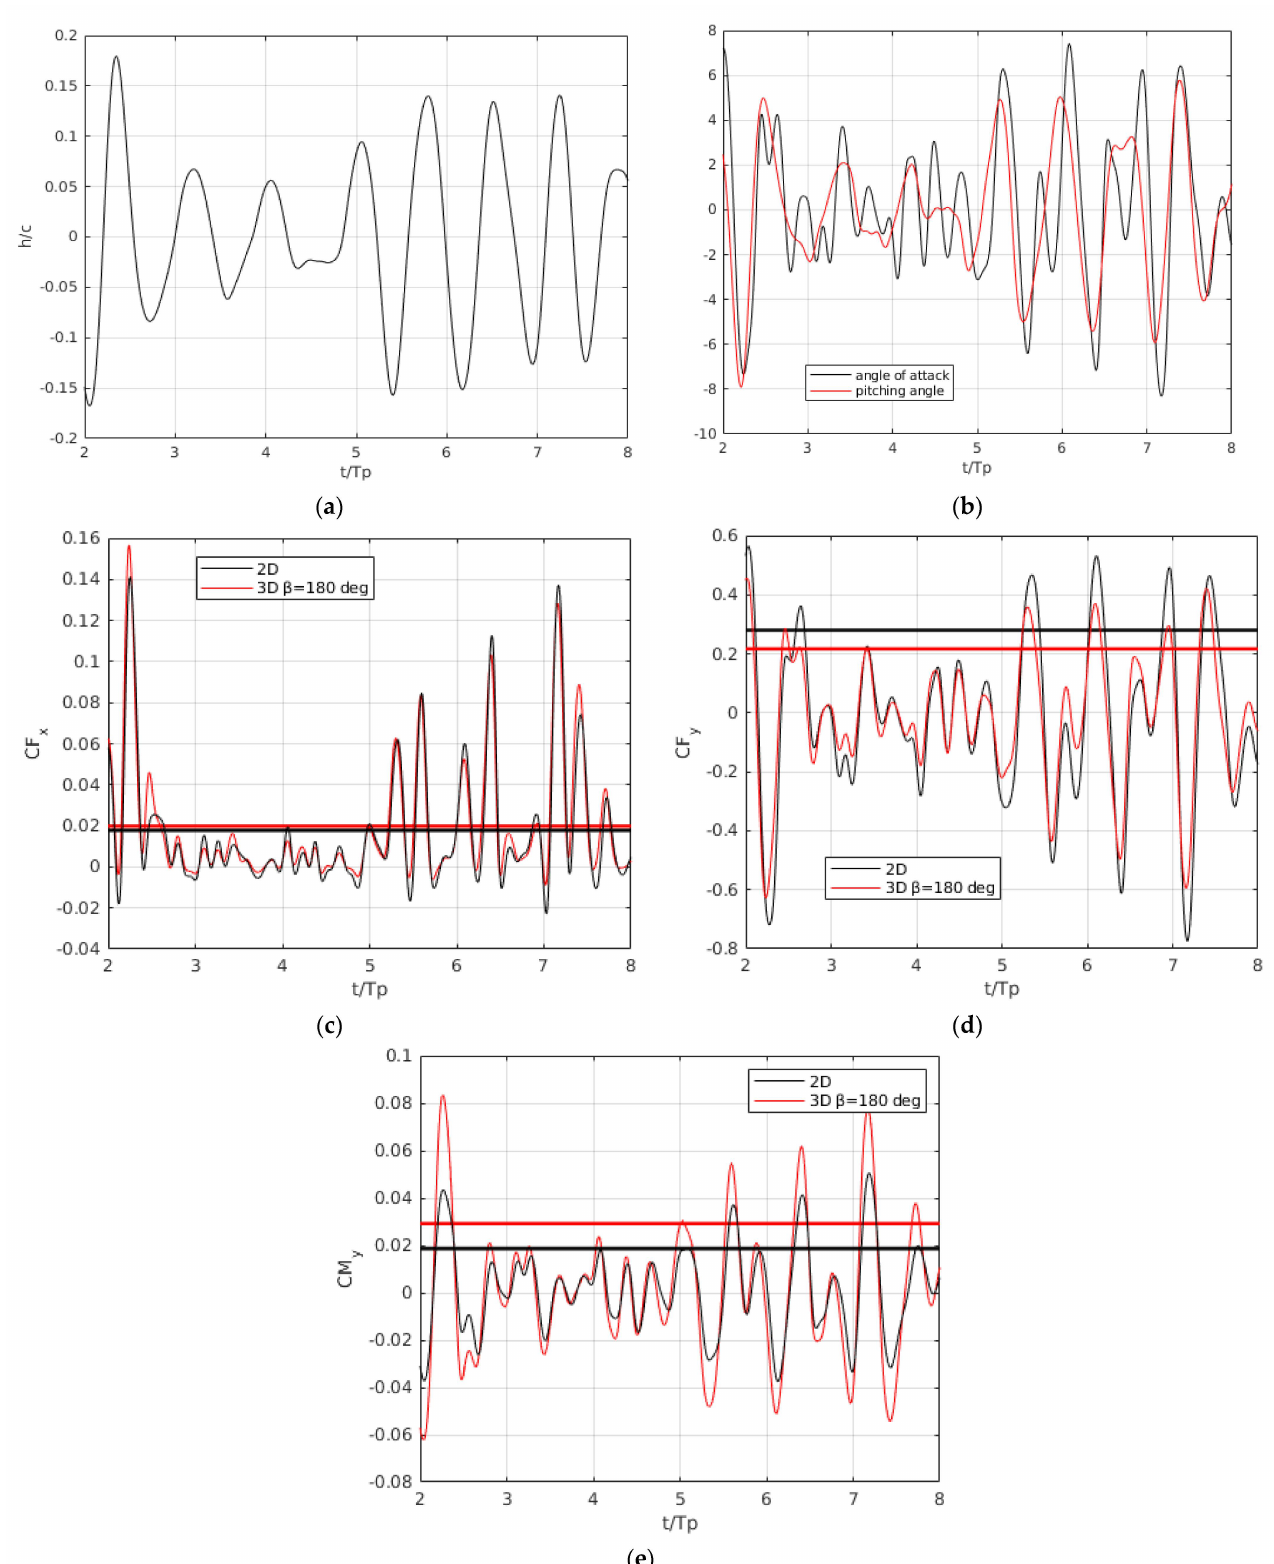
Figure 16. Evolution of motion and loads acting on the dynamic wing in head waves ( β = 180 ◦ ) for the case of Figure 15. Comparison between 2D and 3D calculations: ( a ) foil vertical motion; ( b ) pitching angle and angle of attack; ( c ) thrust coefficient C Fx = F x /0.5 ρ U 2 cs ; ( d ) lift coefficient C Fz = F z /0.5 ρ U 2 cs ; ( e ) foil moment about its pivot axis C My = M y /0.5 ρ U 2 c 2 s